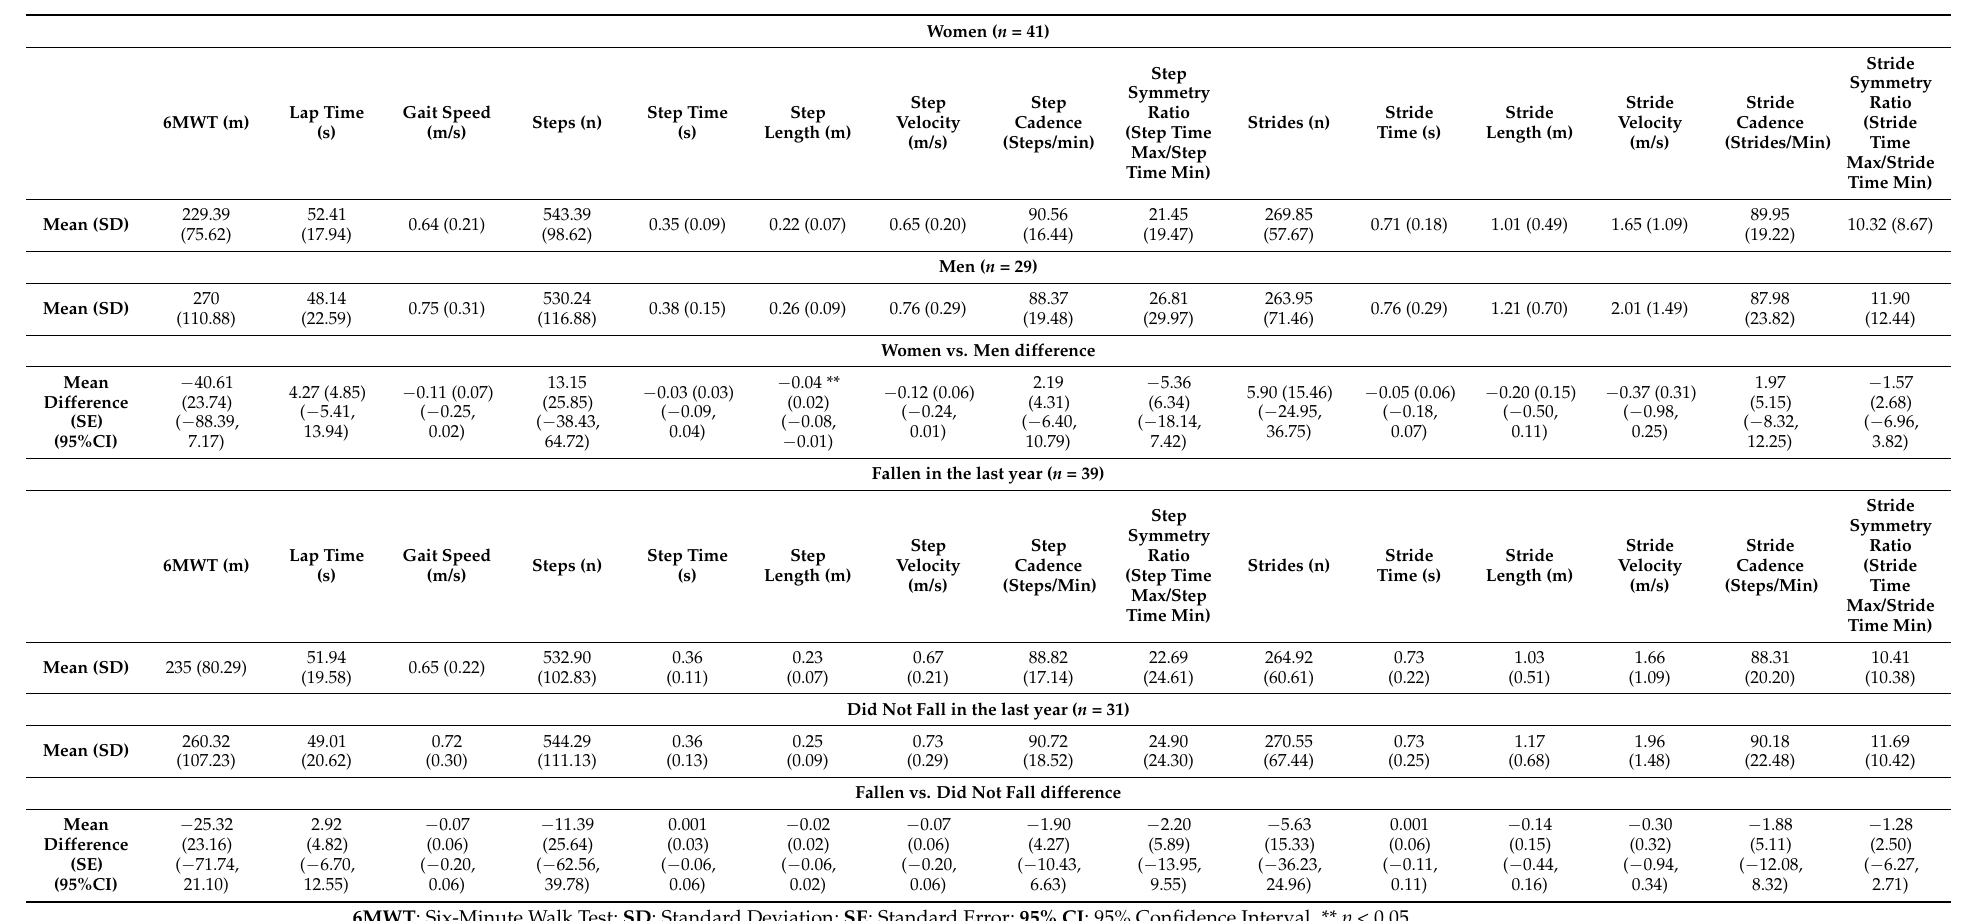
Table 5. Kinematic gait parameters differences between women and men and between patients who had fallen in the last year and those who did not fall in the last year in the